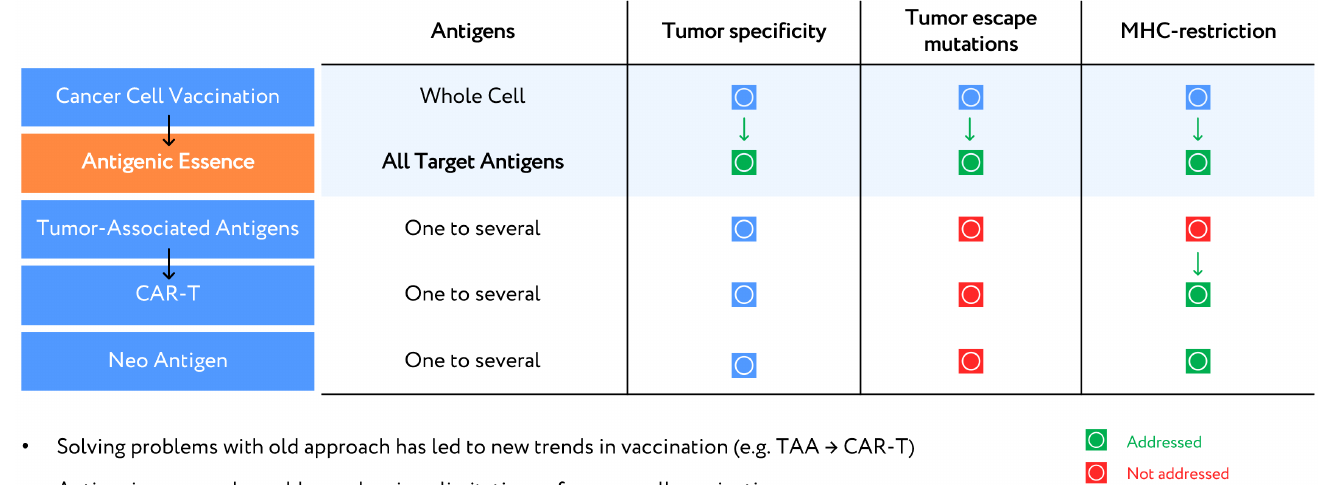
Figure 1. Anticancer vaccination approaches.